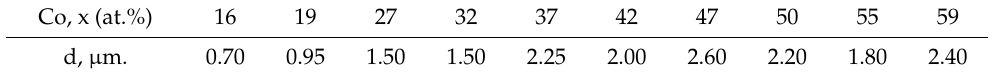
Table 1. The atomic concentration and thicknesses of the investigated samples .